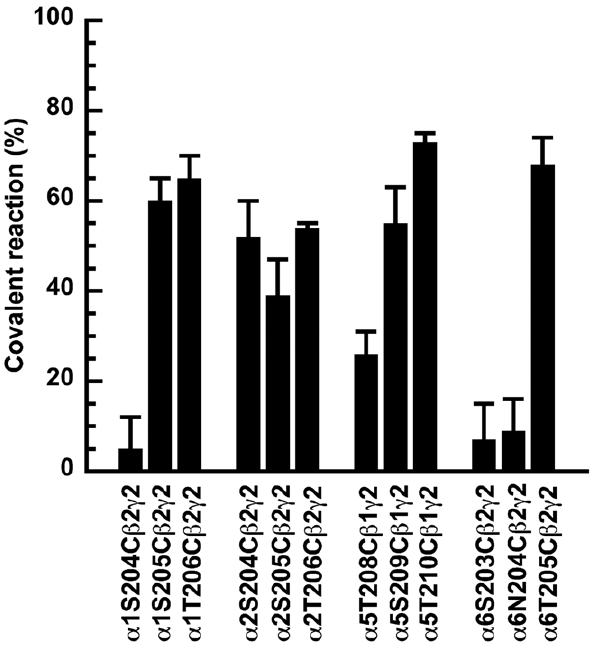
Figure 3. Covalent reaction at the binding level. Extent of covalent reaction of 3-NCS at a 1 S204C b 2 c 2 , a 1 S205C b 2 c 2 , a 1 T206C b 2 c 2 mutant GABA A receptors and homologous receptors formed with a 2 , a